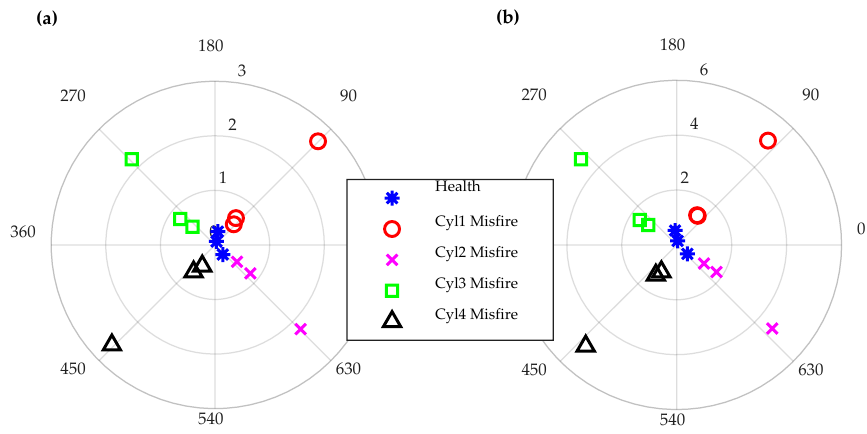
Figure 17. Polar plotting of the fault indicators at 1800 rpm and: ( a ) 0 Nm; ( b ) 105 Nm.